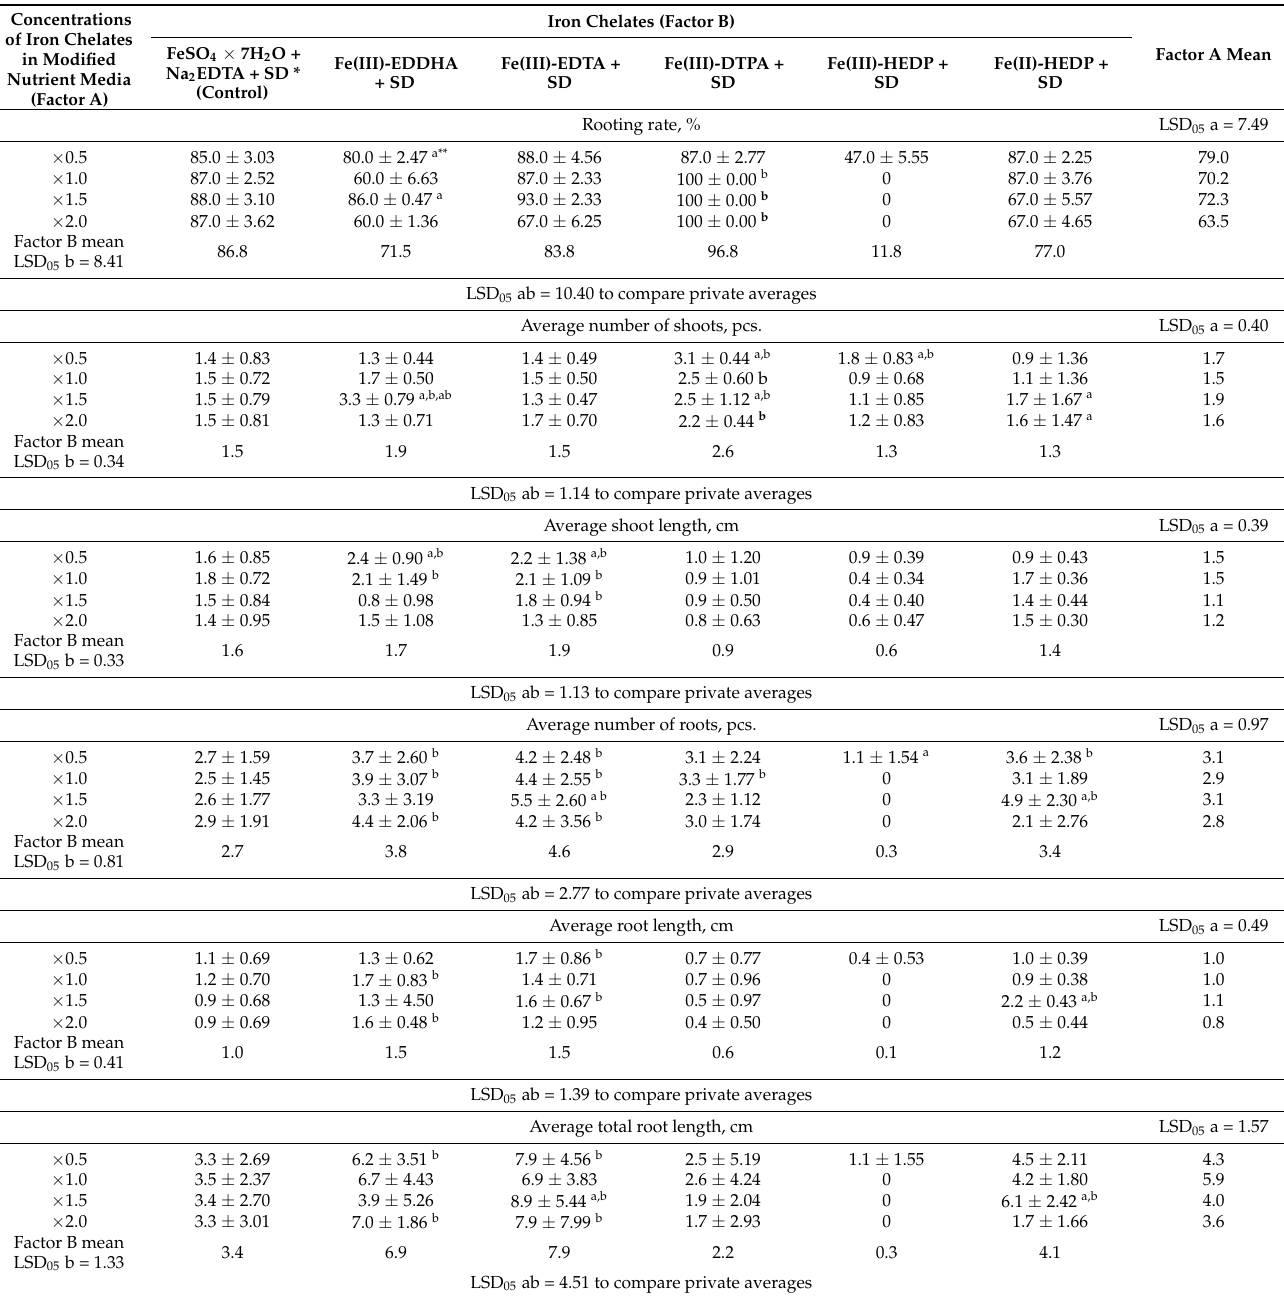
Table 3. The effect of the introduction of chelated iron compounds into the nutrient medium on the development of blue honeysuckle “Lulia” ( Lonicera caerulea var. kamtschatica Sevast.) at the stage of